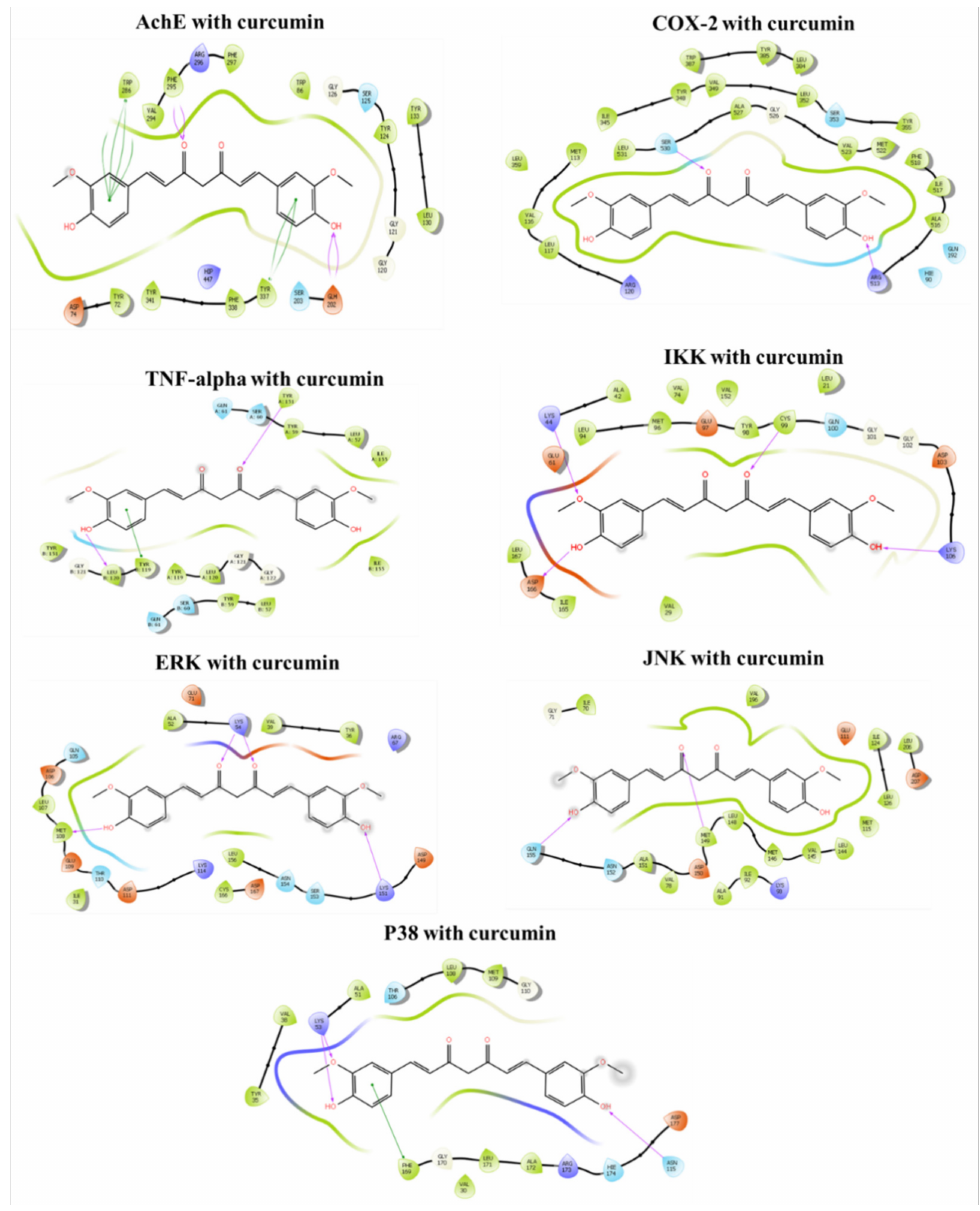
Figure 6. Molecular docking of curcumin with AChE (PDB ID: 4M0E), COX-2 (PDB ID: 5KIR), TNF- α (PDB ID: 2AZ5), IKK (PDB ID: 4KIK), ERK (PDB ID: 1TVO), JNK (PDB ID: 3OY1), and P38 (PDB ID: 5WJJ). Here, the colors indicate the residue: orange—acidic (Asp, Glu); green—hydrophobic (Leu, Trp, Ala, Val, Ile, Met, Cys, Pro, Tyr, Phe); purple—basic (Lys, His, Arg), blue—polar (Thr, Gln, Ser, Asn, Hie, His, Hid); grey (Gly and water). The line between receptor and ligand indicates the interaction: pink (H-bonds to the protein backbone); orange ( π -cation interaction); green ( π - π stacking interactions). The protein “pocket” is visualized with the colored line around the